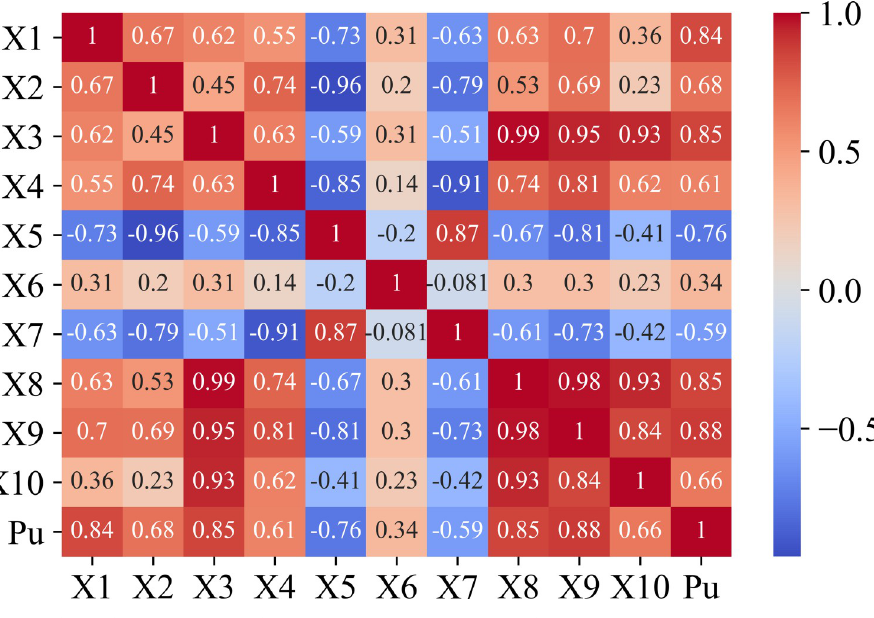
Fig 3. Relation between input and output via matrix Pearson